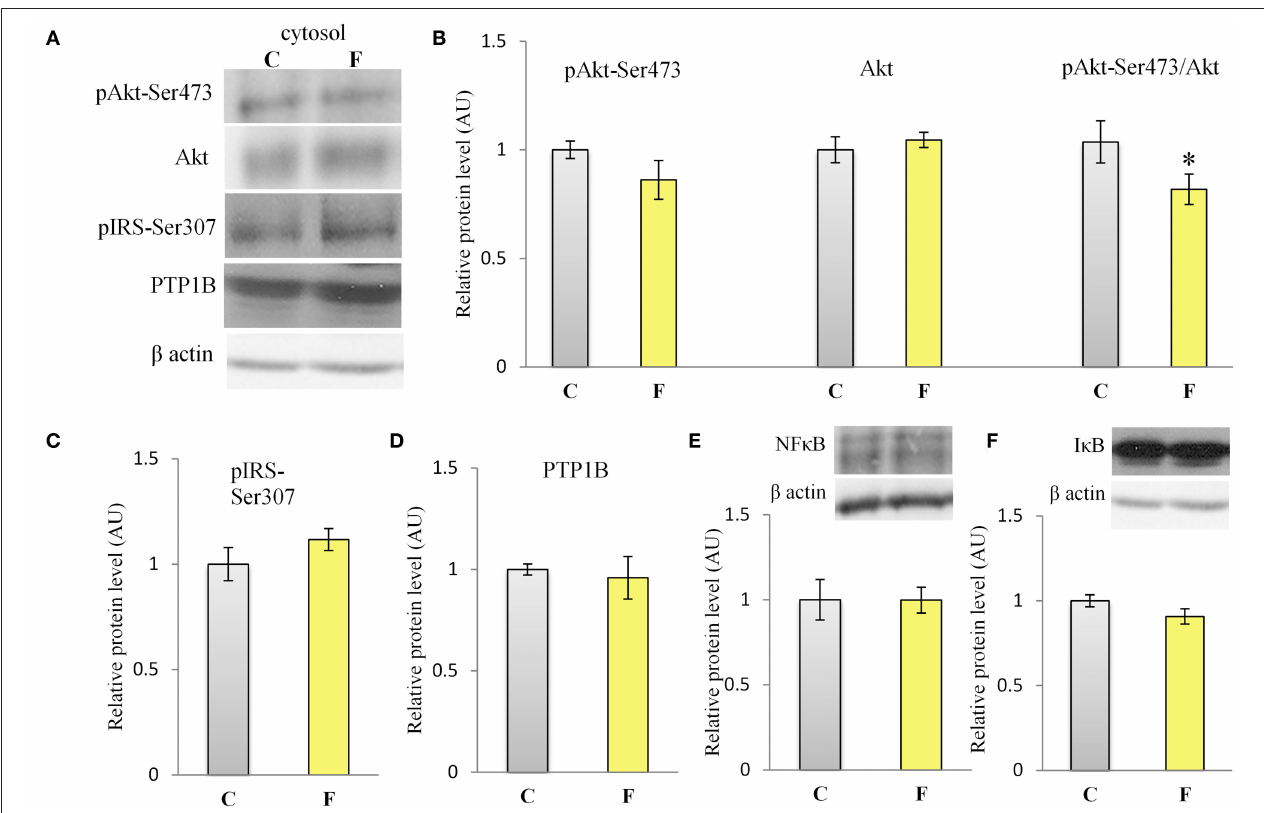
FIGURE 7 | Insulin signaling and inflammation in the VAT of male rats fed with 10% fructose diet for 9 weeks. (A) Representative Western blots (A) and relative quantification for protein levels of Akt, pAkt-Ser473 and its ratio to total (B) Akt, (C) pIRS1-Ser307, (D) PTP1B, (E) NF κ B, and (F) I κ B. All protein levels were measured by Western blot in the cytosols of the VAT from control (C) and fructose-fed (F) female rats, normalized to β actin and expressed in arbitrary AUs. The values represent the mean ± SEM ( n = 8 animals per group). Statistical significance of between-group differences (Student’s t -test): * P < 0.05, F vs. C.